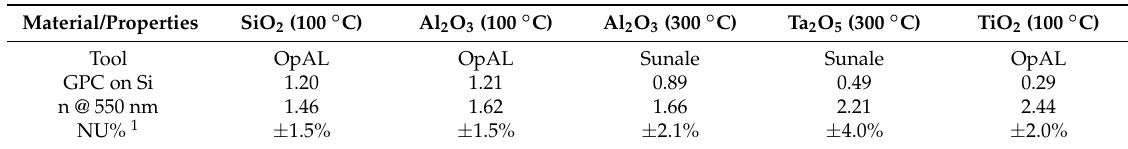
Table 2. Growth rate on silicon substrates (growth per cycles (GPC) in Å/cycle), refractive index and thickness non-uniformity over a 200 mm area of deposited ALD thin films. The corresponding deposition temperatures are given in